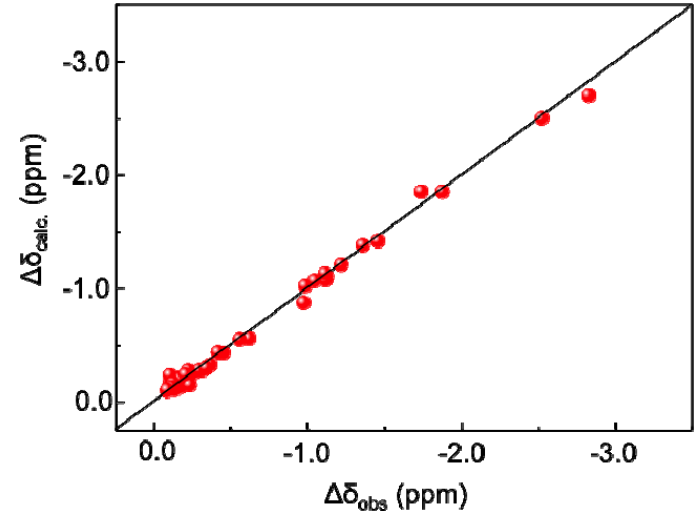
Figure 3. Correlations between the experimentally observed and back-calculated PCS values of the GM2 tetrasaccharide with Tm 3+